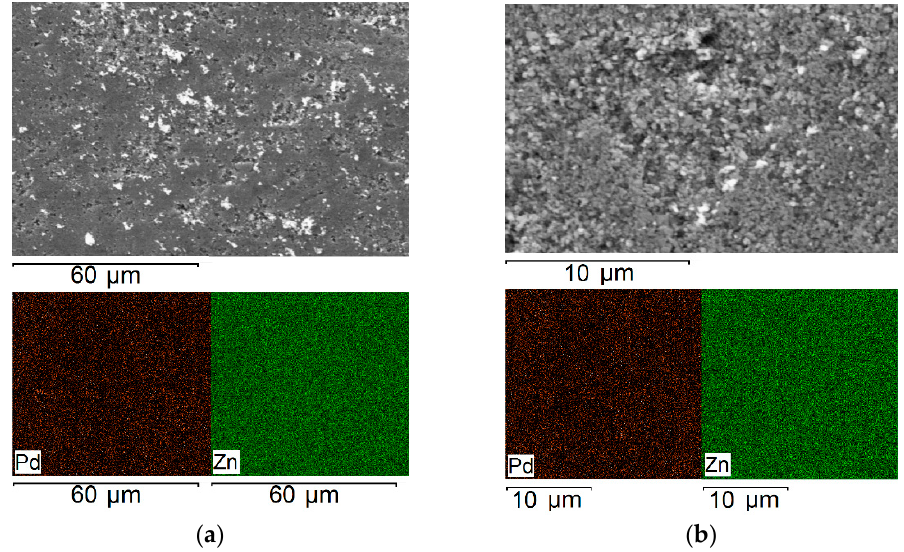
Figure 2. SEM and EDX mapping images of Pd and Zn from the 0.5%Pd/ZnO ( a ) and 0.5%Pd-PVP/ZnO ( b ) catalysts.